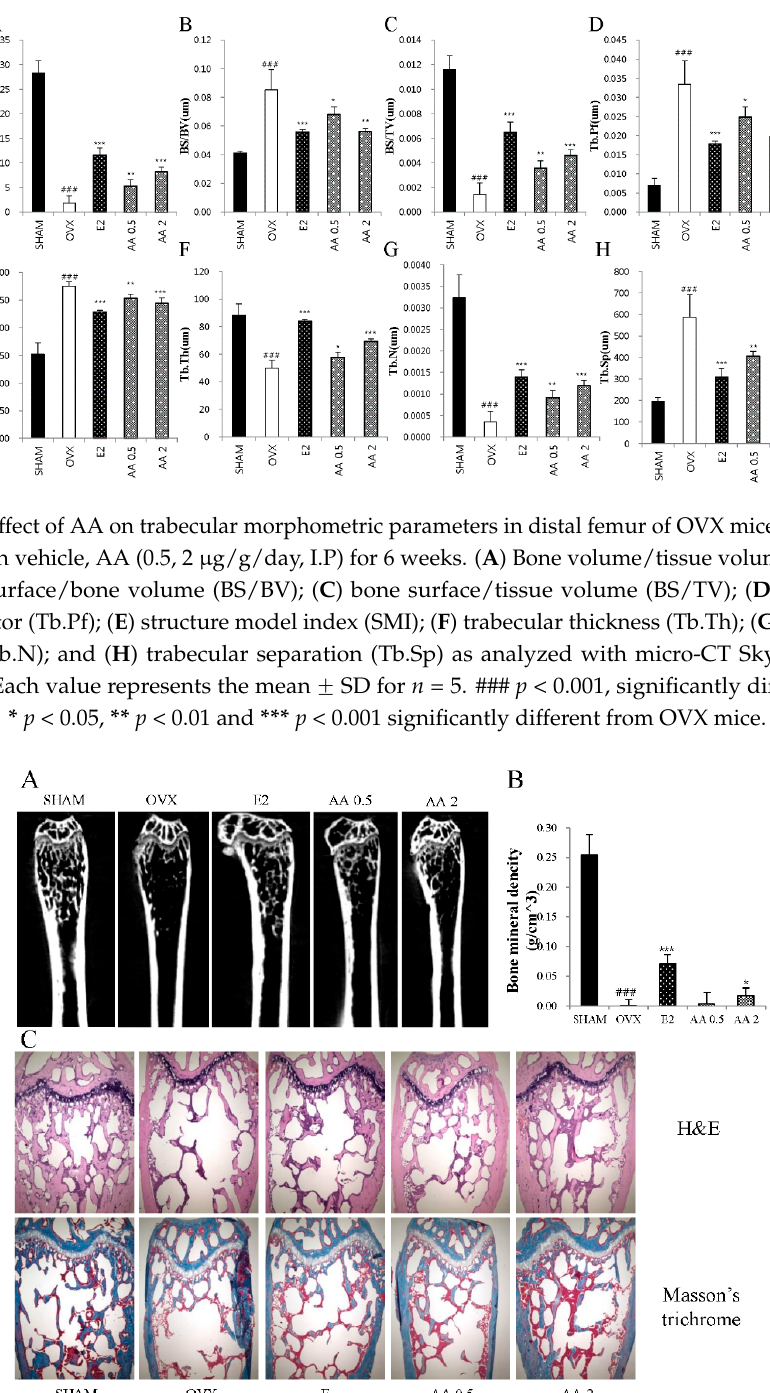
Figure 5. The effect of treatment with AA (alisol A-24 acetate) on the femur trabecular microarchitecture in OVX (ovaritectomy) mice: ( A ) two dimensional micro-computed tomography (micro-CT) images of the femoral trabecular bone; ( B ) bone mineral density (BMD) was assessed by micro-CT; and ( C ) histological analysis of femur with H & E and Masson’s trichrome staining. Magnification: 40-fold. Each value represents the mean ± SD for n = 5. ### p < 0.001, significantly different from sham mice. * p < 0.05 and *** p < 0.001 significantly different from OVX mice.